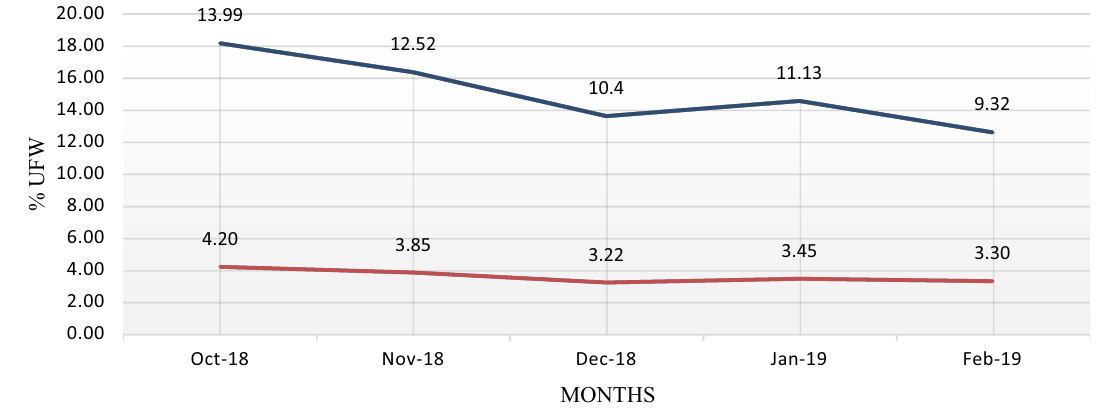
Fig. 8 Graphical comparison of percentage of water loss before and after